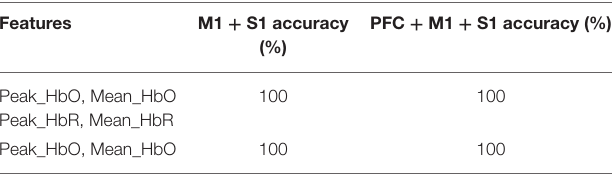
TABLE 3 | Classification accuracies of the motor imagery task for a typical patient with MCS (Patient 1).